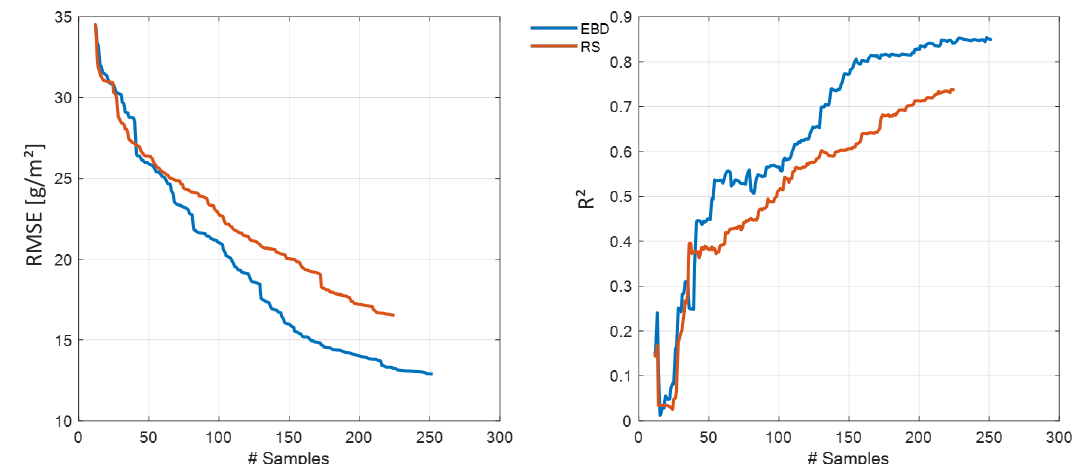
Figure 4. Goodness-of-fit statistics ( left ): RMSE and ( right ): R 2 for non-photosynthetic cropland biomass retrieval applying the EBD method and random sampling (RS) on a PROSAIL-PRO simulated training database against in situ data.